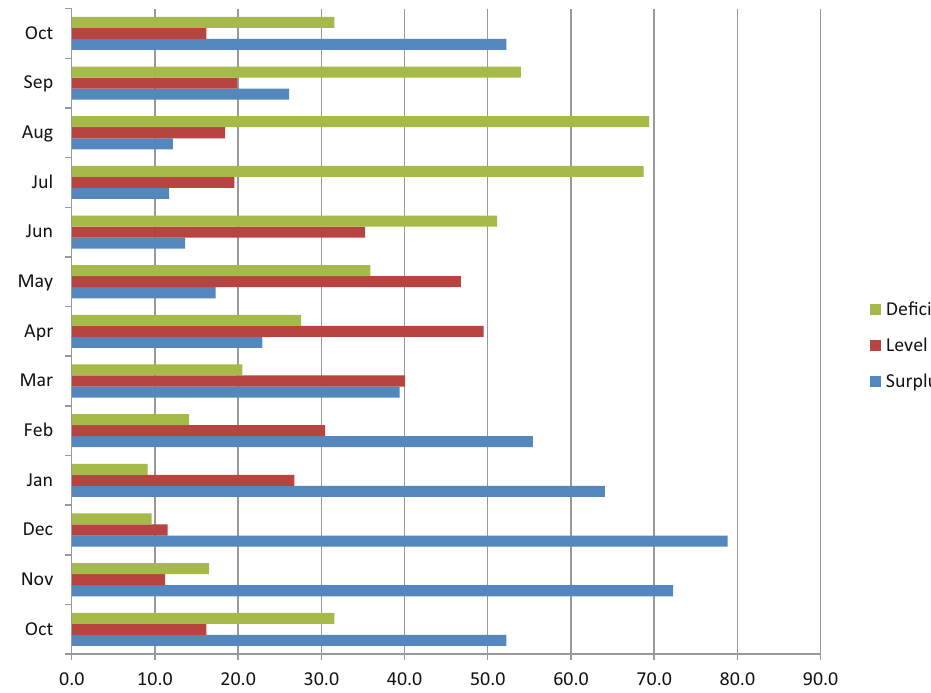
Figure 4: Food availability status at farm level ( irrespective of IRV adoption ) . Source: Authors ’ survey,